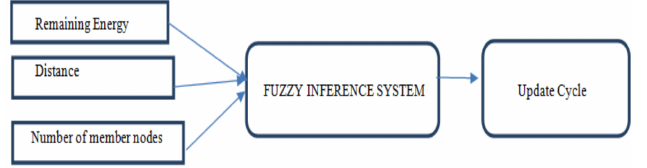
Figure 1. Fuzzy inference system.